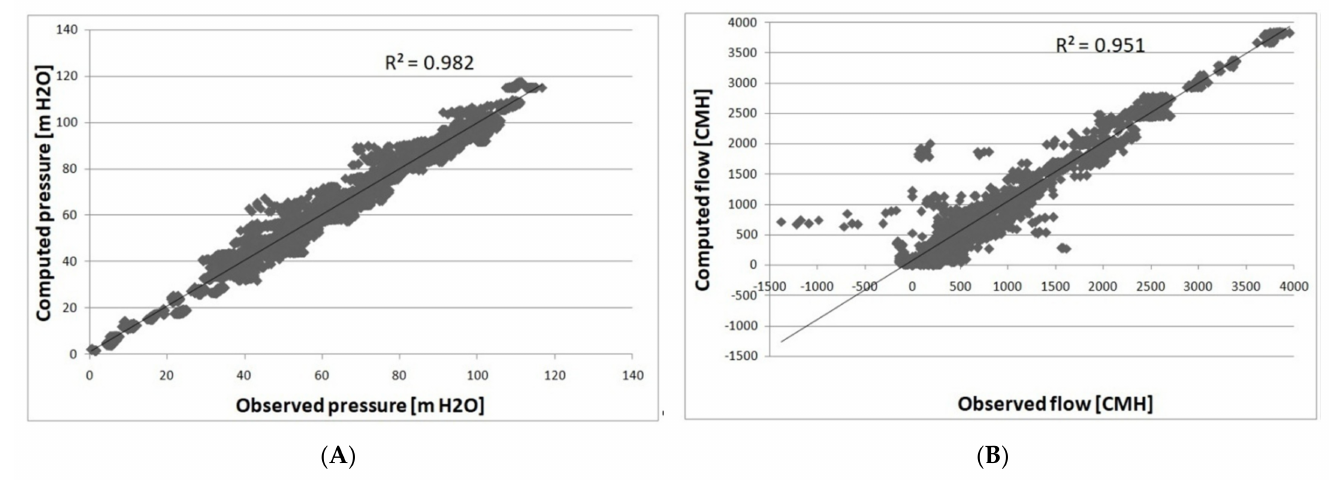
Figure 6. Correlation plot between the observed and simulated values. ( A )—pressure; ( B